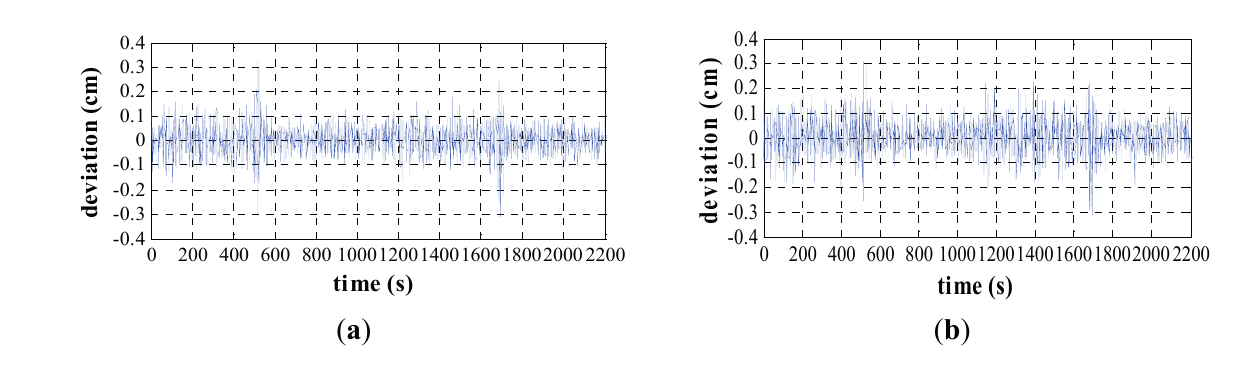
Figure 6. Error curves of vessel dynamic accuracy. ( a ) Latitude error. ( b ) Longitude error. ( c ) Positioning